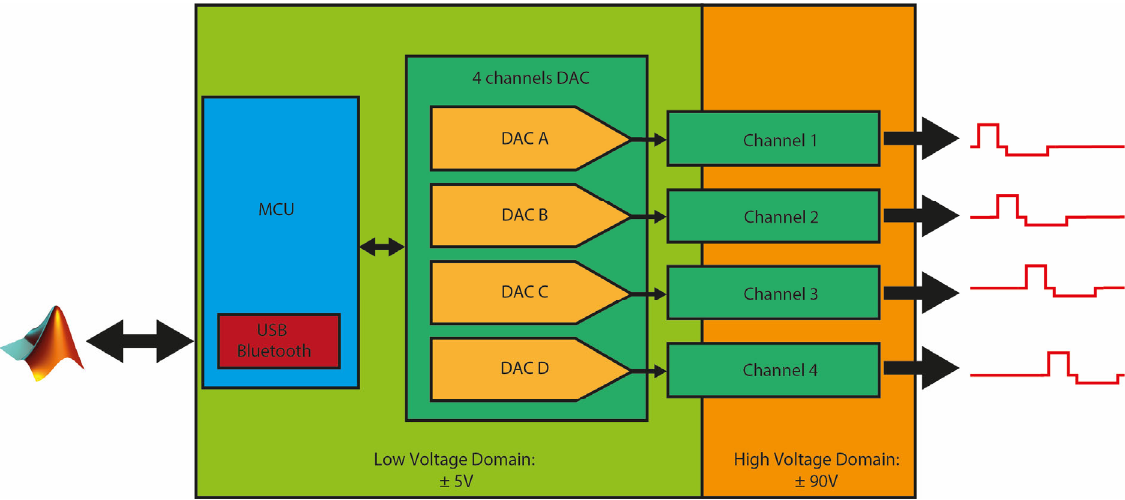
Figure 2. Block diagram of the proposed system. The platform communicates with MATLAB using MCU built-in USB or Bluetooth peripherals. The MCU controls the four channels DAC allowing to set the desired current in output in each output channel. MCU and DAC work in the low-voltage domain ( ± 5 V), while the output channels operate in the high-voltage domain ( ± 90